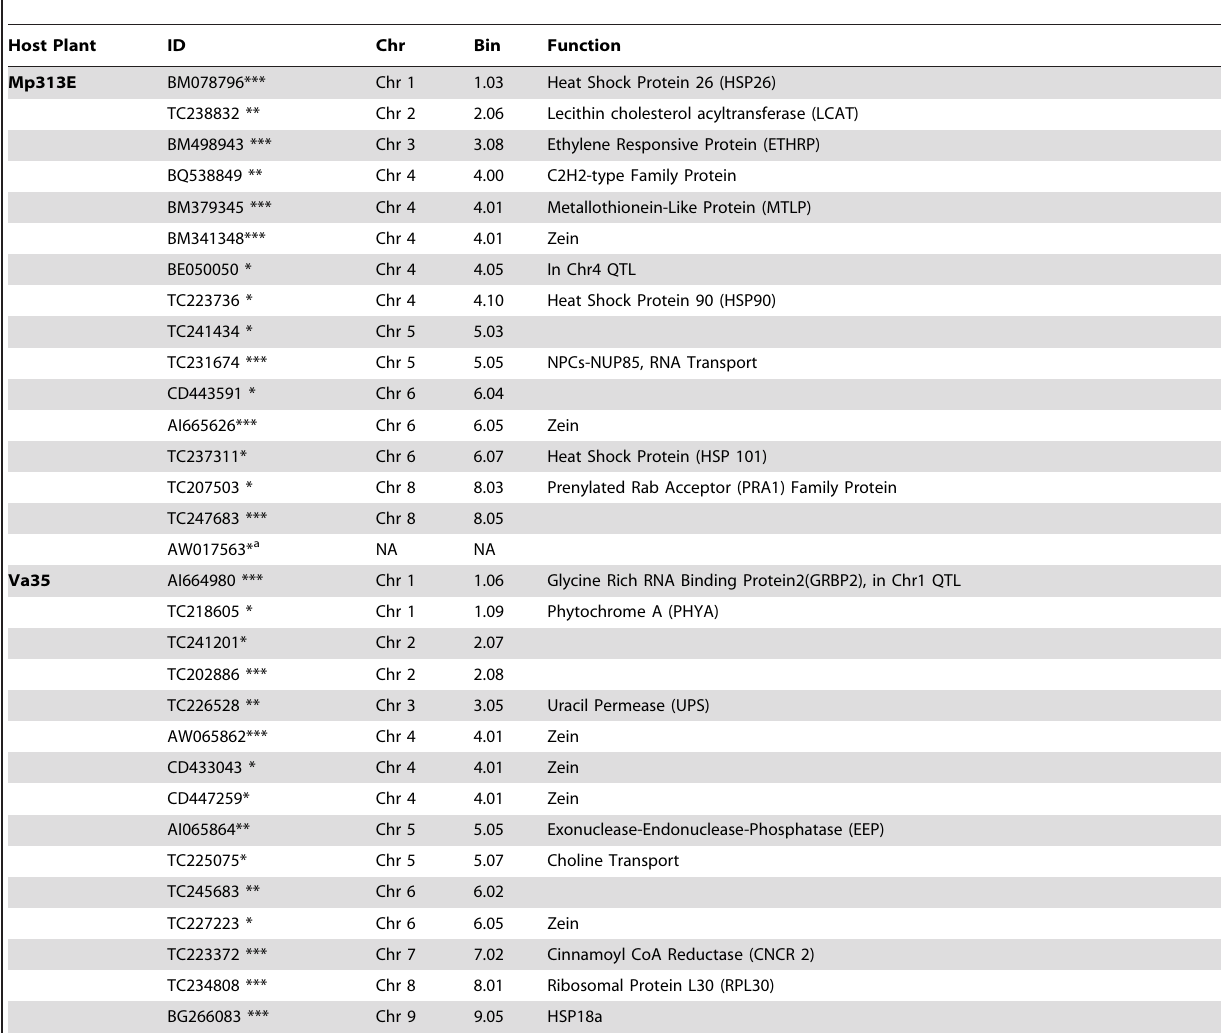
Table 3. Genes differentially expressed in the resistant maize inbred line Mp313E and the susceptible maize inbred line Va35 verified by qRT-PCR